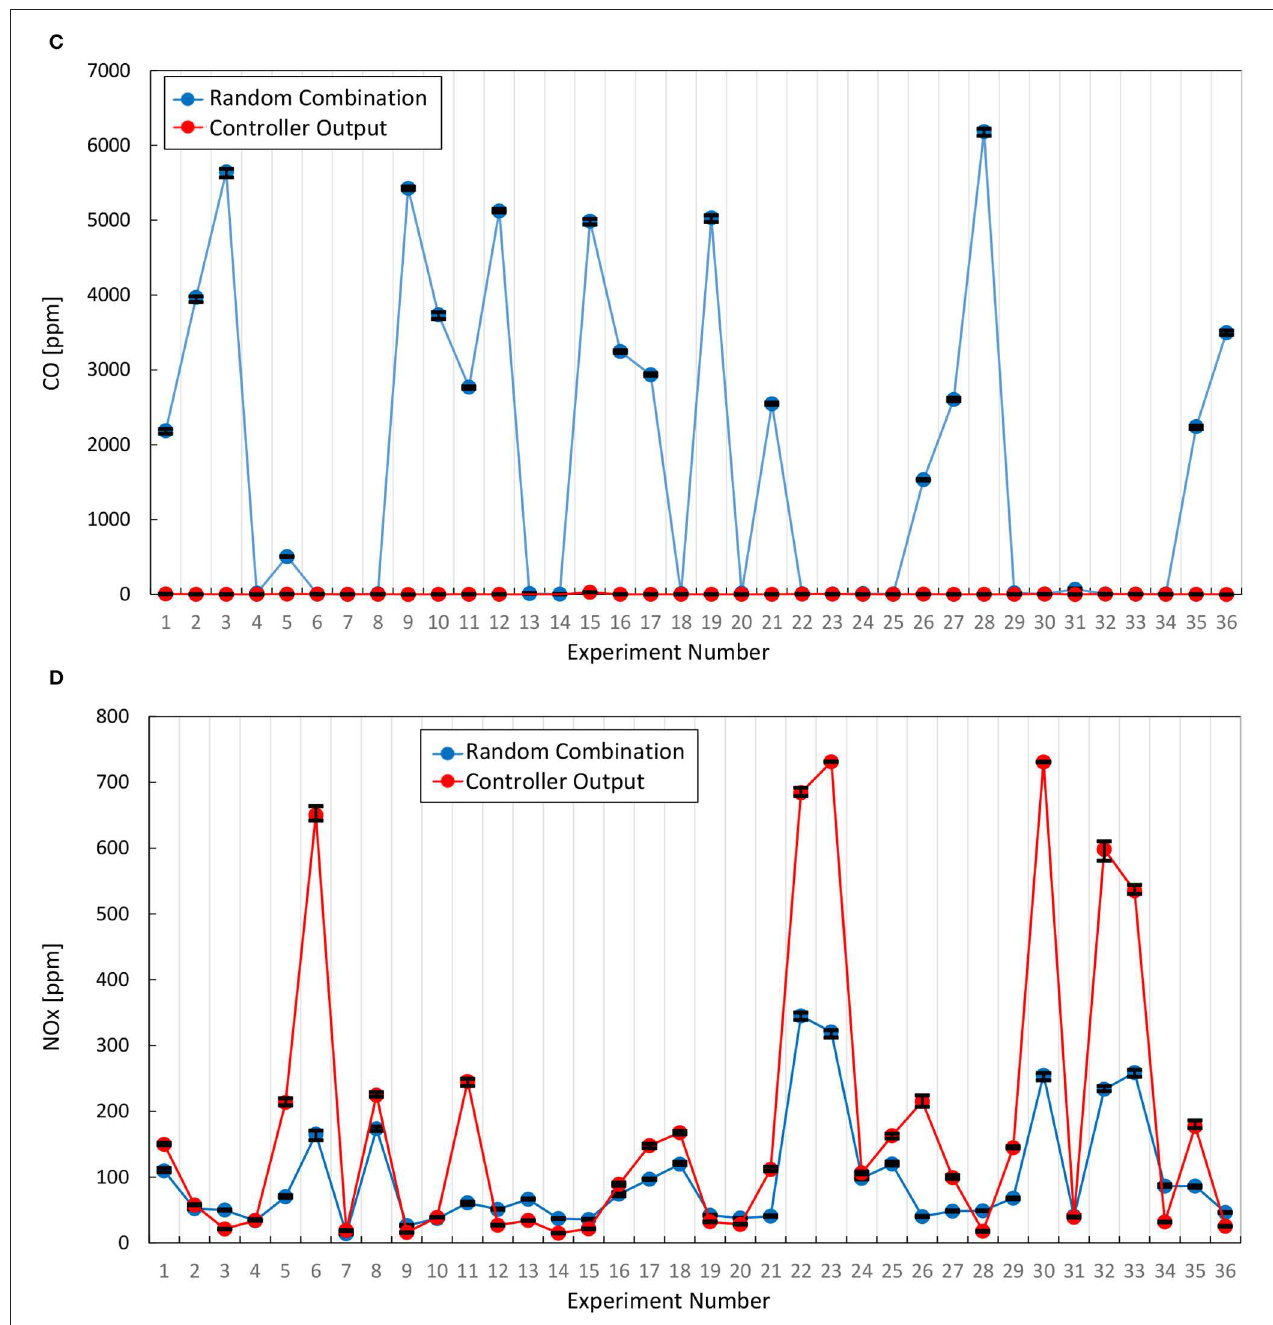
FIGURE 8 | Comparison of combustion efficiency and emissions. (A) Combustion efficiency, (B) THC, (C) CO, (D) NOx.